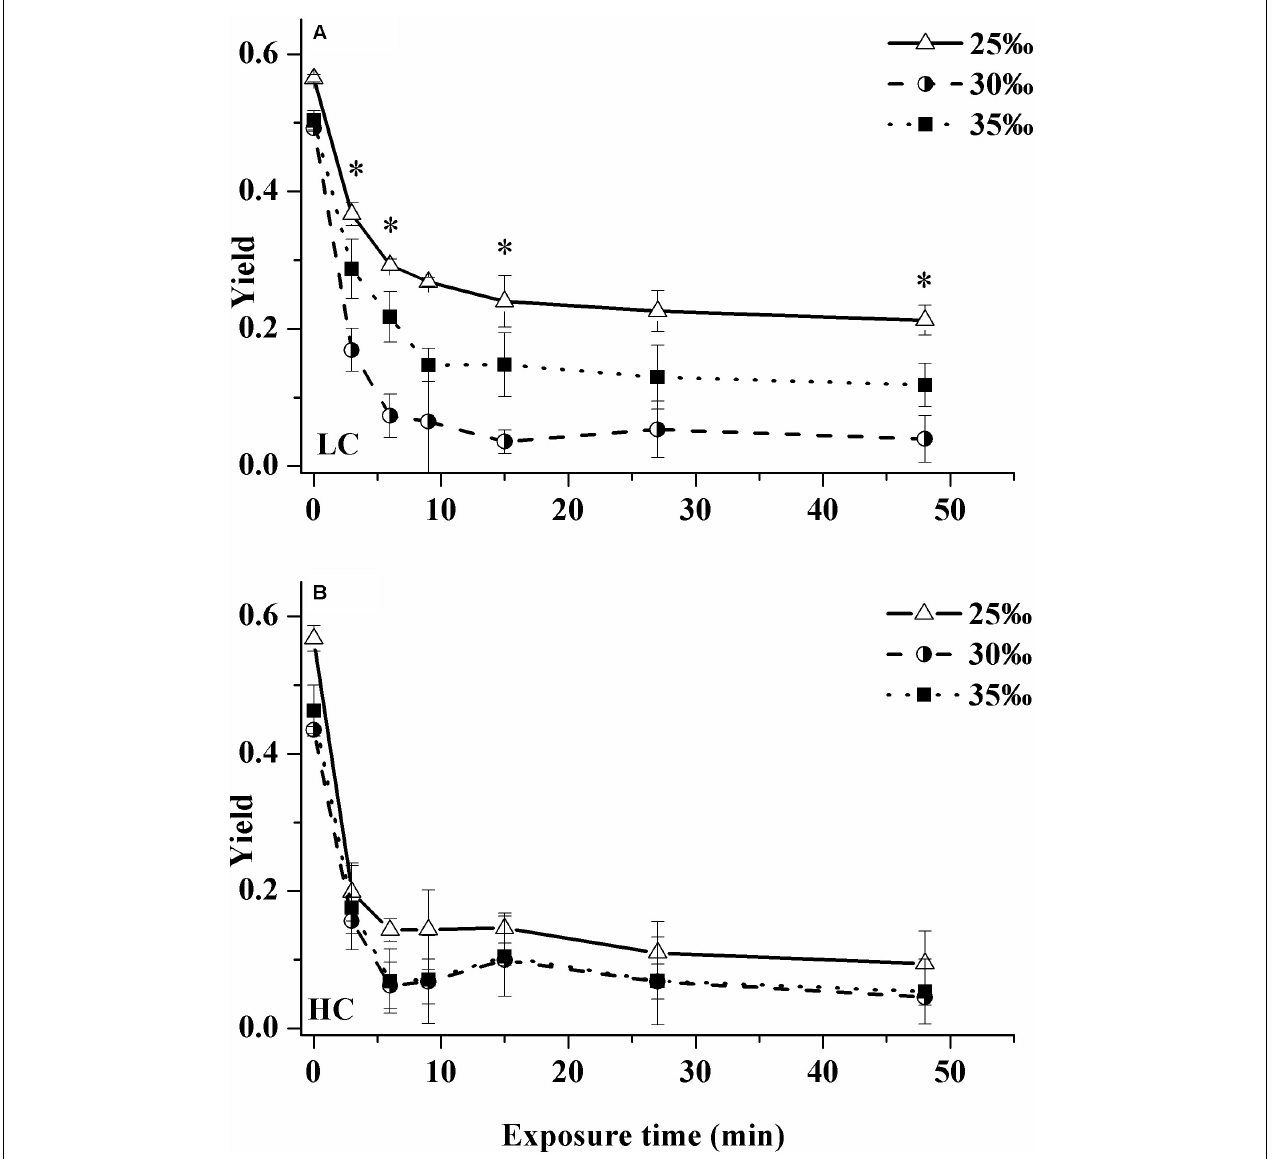
FIGURE 5 | Changes in effective photochemical quantum yield of cells grown under ambient (400 µ atm, LC, A ) and elevated CO 2 (1000 µ atm, HC, B ) when exposed to solar radiation for 48 min (800 µ mol photons m − 2 s − 1 ) under three salinity treatments: 25 squares). Values are means ± SD of triplicate cultures. Asterisks represent significant differences ( p < 0.05) among three salinity